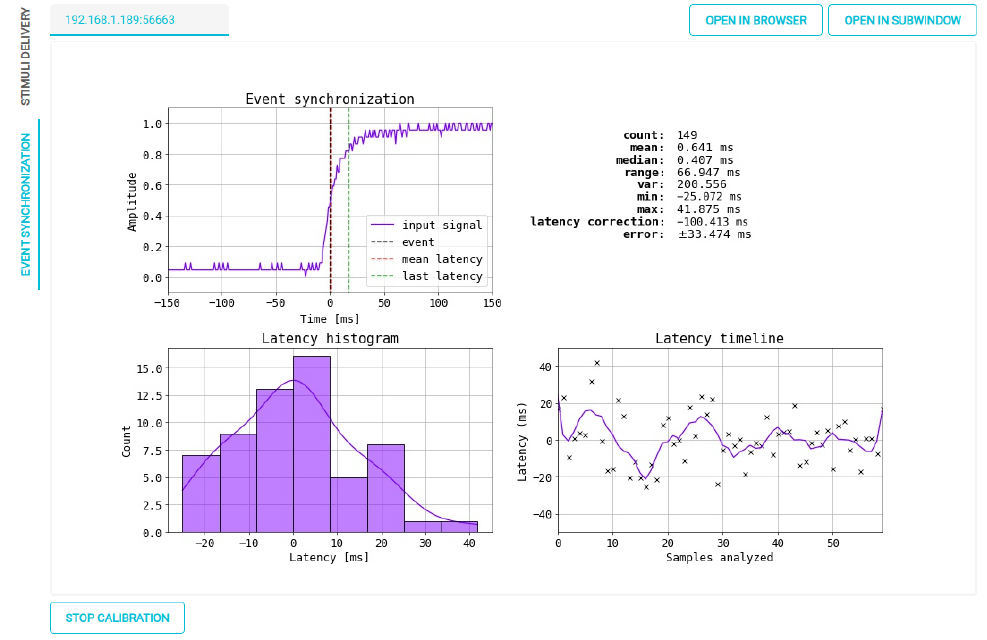
Figure 14. OpenBCI Framework results for marker synchronization within the real-time